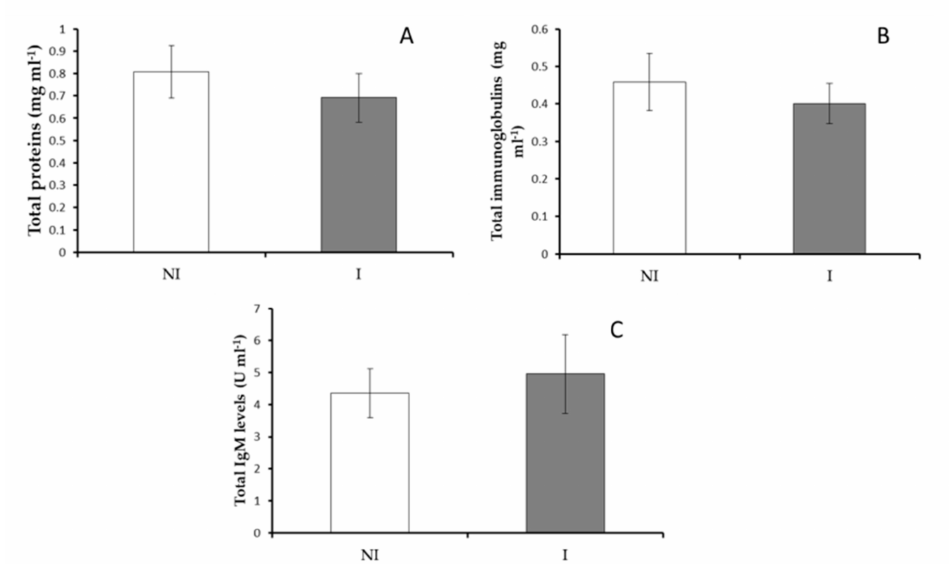
Figure 2. Skin mucus immune response in non-infected (NI) and infected (I) European sea bass. ( A ) Total protein levels, ( B ) total immunoglobulin levels and ( C ) total IgM levels. Data are represented as means ± standard error of the mean (SEM, n = 9).